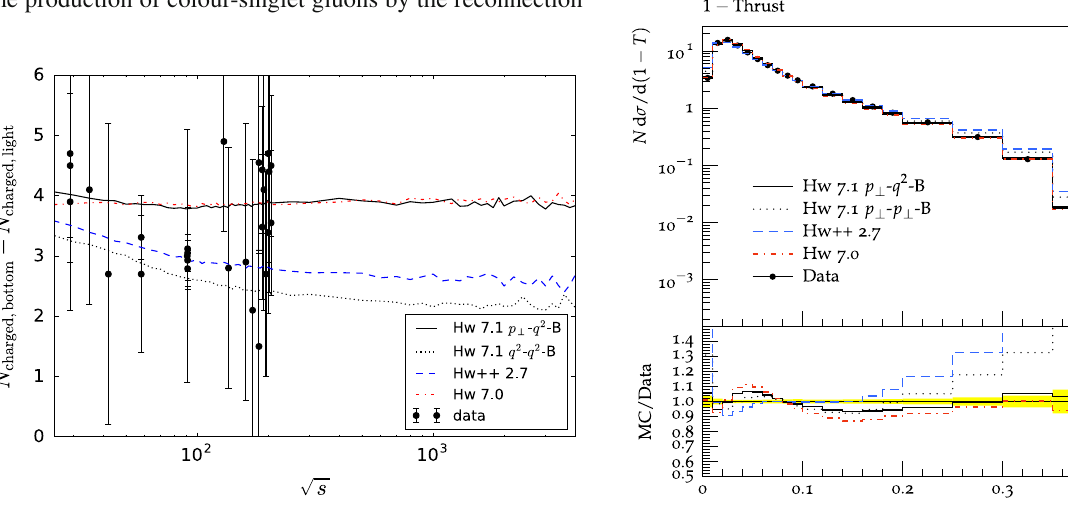
Fig. 10 The thrust at the Z-pole compared with data from the DEL- PHI [43] experiment